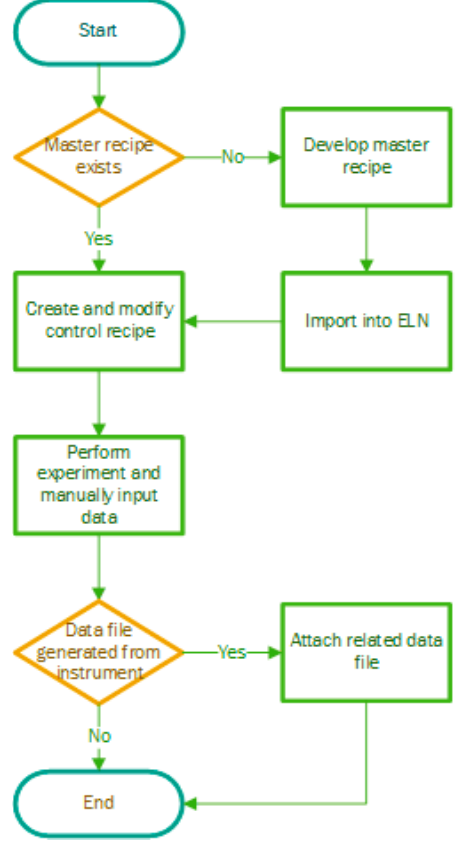
Figure 5. Workflow of using electronic lab notebook (ELN) to perform an experiment.